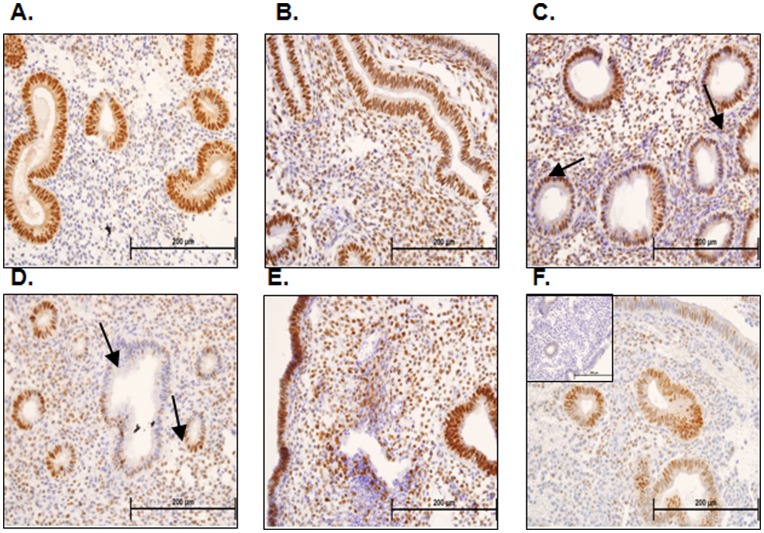
Progesterone receptor immunohistochemistry and semi-quantitative analysis.Progesterone receptor (PR) consistently immunolocalizes to the glandular epithelial cells of endometria taken from fertile women at LH+2 (A). In fertile ovum donors stimulated with the GnRH protocol PR immunostaining is localized to glandular epithelial cells, luminal epithelial cells and stromal cells on hCG+2 (B). PR staining is similarly patchy in the glandular epithelial cells of endometria taken from infertile women stimulated with GnRH antagonist at hCG+2 (C & D, arrows) and in the stroma (C & D). PR immunostaining localizes to the glandular epithelial cells, luminal epithelial cells and stromal cells of endometria of infertile women undergoing the GnRH agonist protocol who did not subsequently become pregnant at hCG+2 (E). PR immunolocalized mainly to the glandular epithelium with patchy luminal epithelial and stromal staining in endometria of infertile women undergoing the GnRH agonist protocol who subsequently become pregnant at hCG+2 (F).